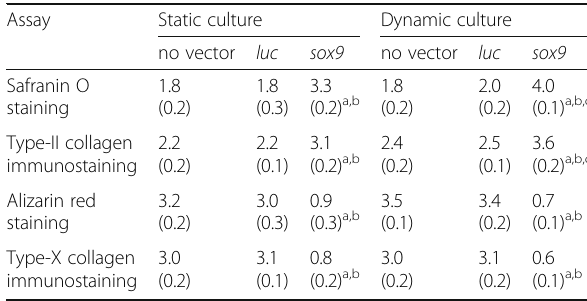
Table 4 Histomorphometric analyses in the rAAV-transduced human bone marrow aspirates (day 28)